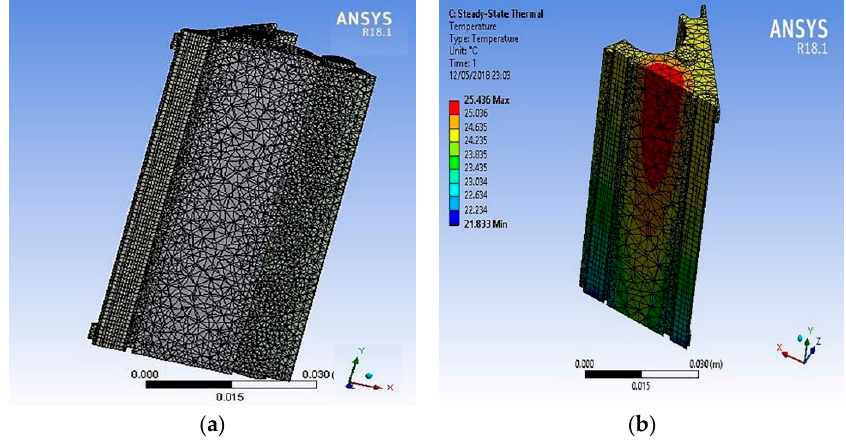
Table 1. Properties of the materials used in the LIB cell modelling.